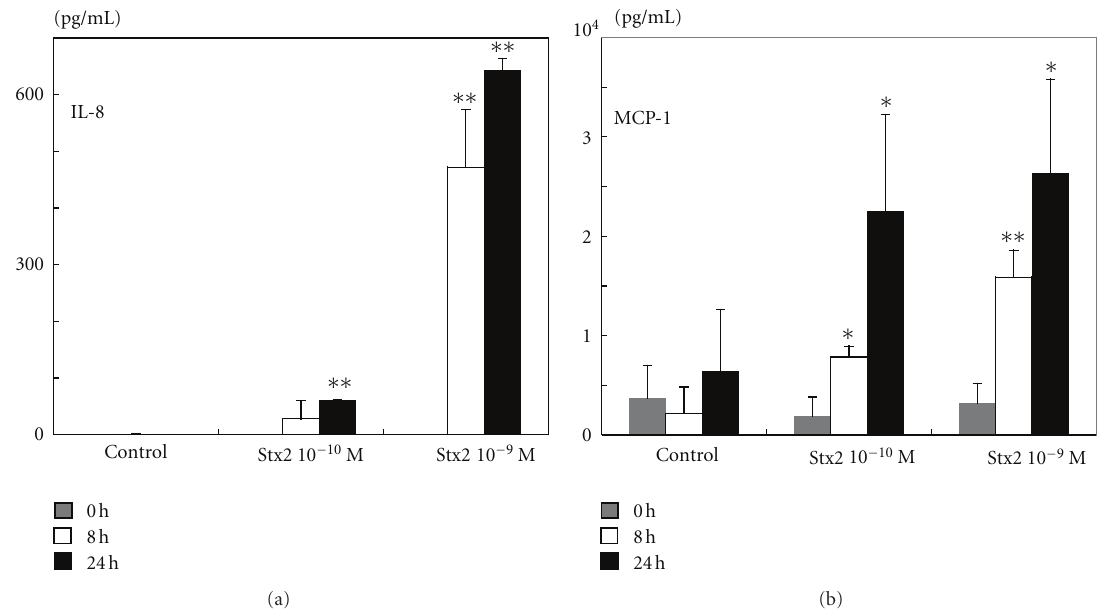
Figure 4: Chemokine release by HASTs upon stimulation with Stx2. Secretion of IL-8 (a) and MCP-1 (b) by HASTs treated with 10 − 9 or 10 − 10 mol/L Stx2 for 24 or 48 h. IL-8 and MCP-1 were measured in cell culture supernatants using ELISA. Data are the means ± SD from the five experiments. Levels of Stx2-induced IL-8 or MCP-1 and those in the untreated controls were calculated. ∗ P < 0 . 05 and ∗∗ P < 0 .